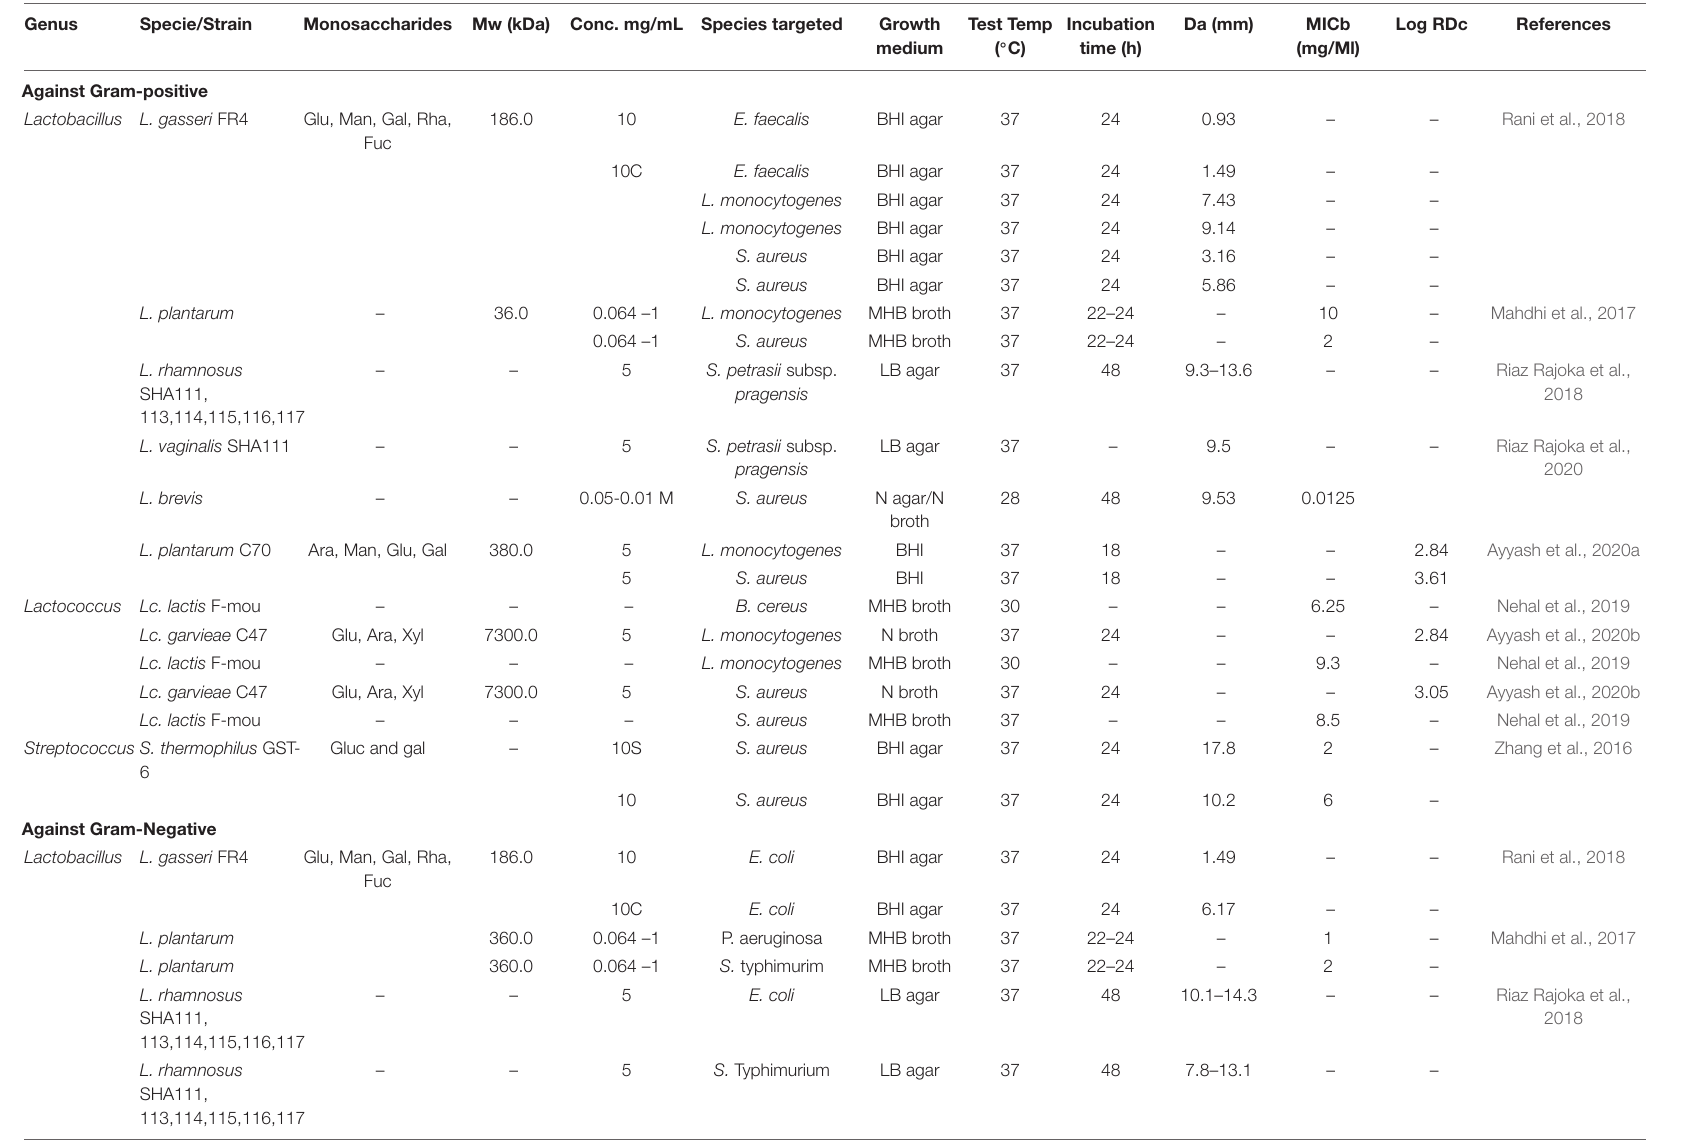
TABLE 1 | Antibacterial activity of LAB-derived EPS against Gram + and Gram − bacterial pathogens.